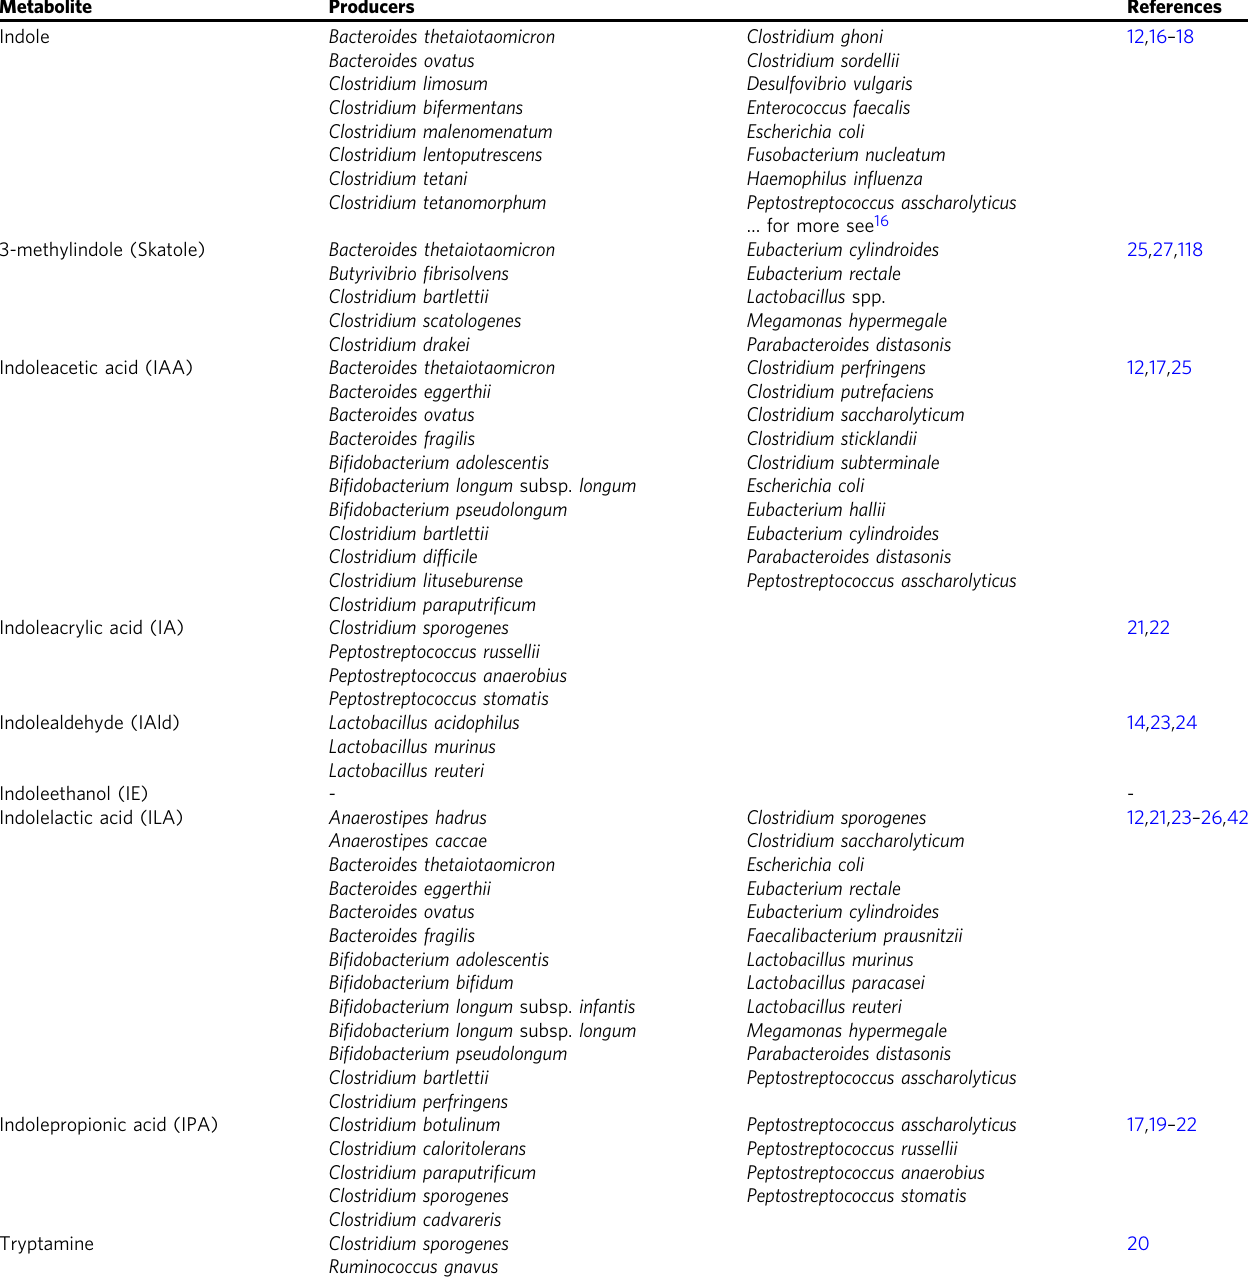
Table 1 Gut bacterial species reported to produce tryptophan catabolites